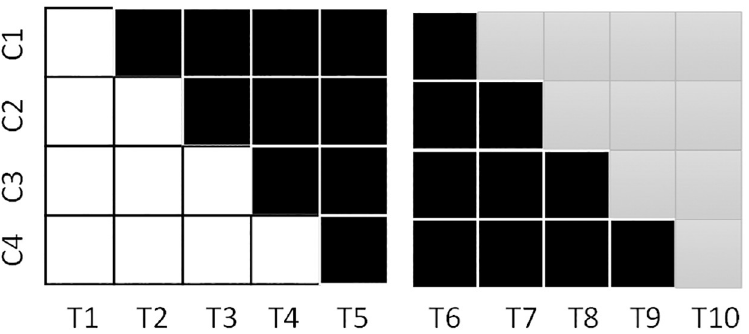
Fig 2. Disinvestment stepped-wedge followed by conventional. White = current service condition, Black = no service condition, Grey = newly developed service condition.